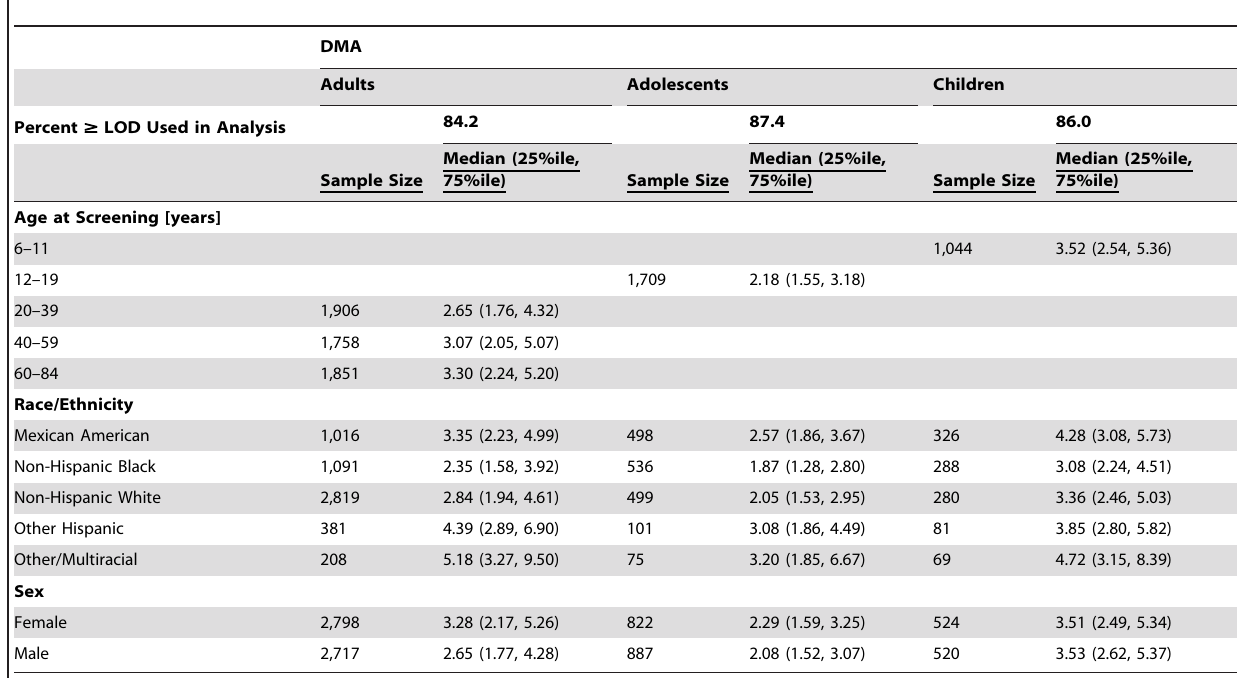
Table 2. Sample-weighted 25 th , 50 th , and 75 th percentiles for creatinine-adjusted urinary DMA [ m mol/mol Cre] for NHANES 2003– 2010 data used in the regression models displayed in Tables 3 and